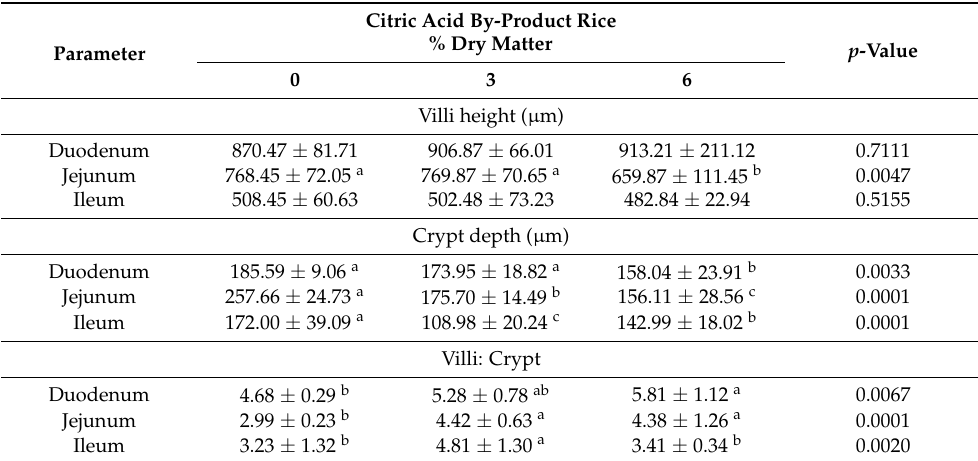
Table 3. Morphological measurement of villi in Thai native chicken (KKU 1) on duodenum, jejunum, and ileum, fed with citric acid by-product from rice (CABR).